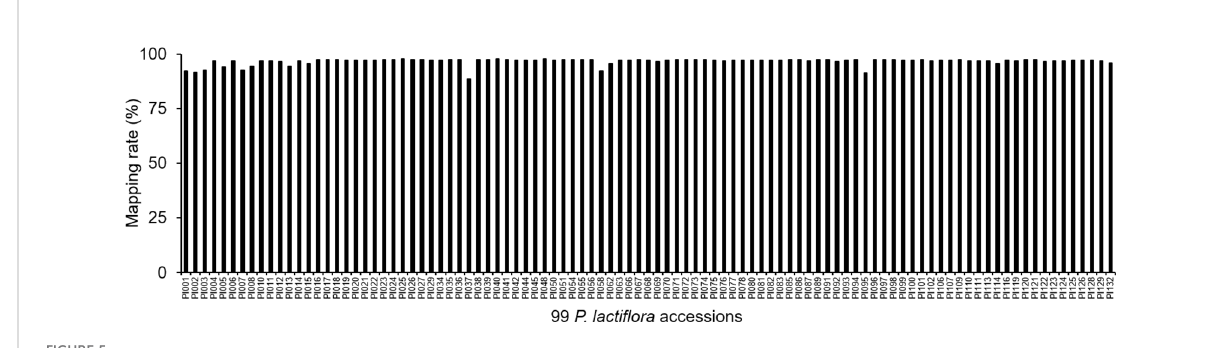
FIGURE 5 Mapping rates of reads from 99 P. lacti fl ora accessions mapped to Paeonia suffruticosa genome.